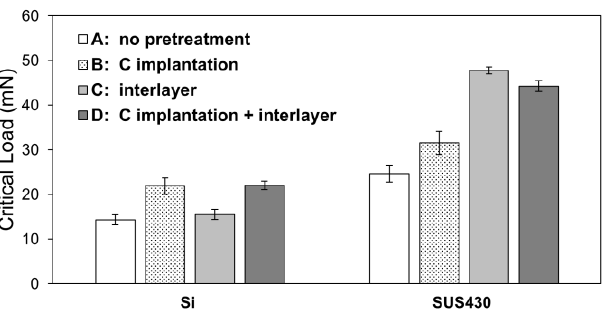
Figure 10. The critical loads of a-C:H films deposited at a trench depth of 2 mm on the Si and SUS430 plates with different pretreatments.